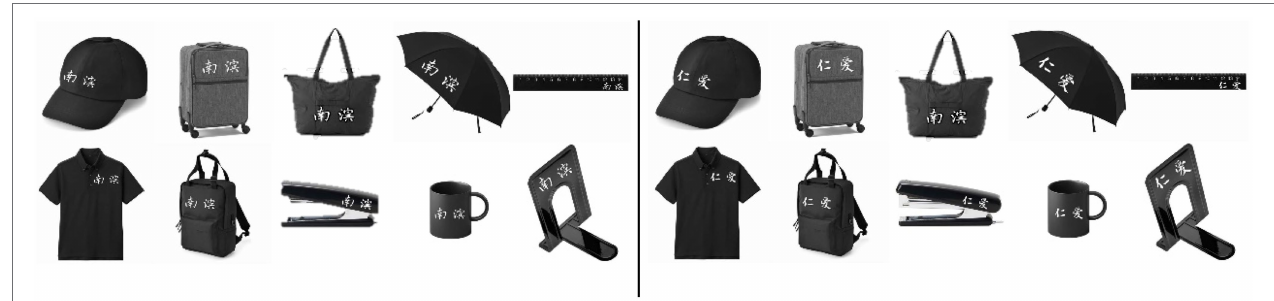
FIGURE 1 | Stimuli used in the study. The images on the left side depict in-organization objects, which were marked with the name of the subjects’ own organization “ 南 滨 ” (i.e., NanBin). The images on the right side depict out-organization objects marked with the name of the other organization “ 仁 爱 ” (i.e., Ren’ai).